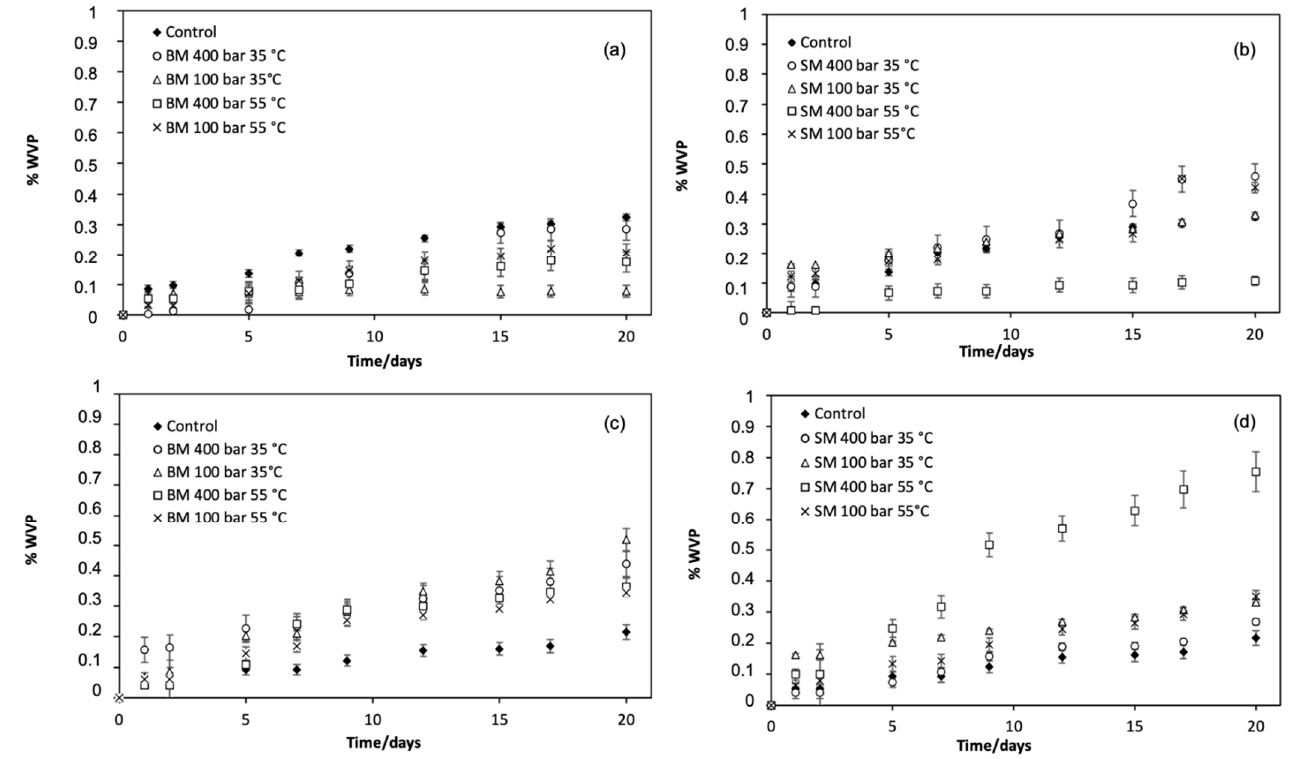
Figure 3. Percentage WVP of untreated PET/PP film (control) and OLE-impregnated films at ( a , b ) 20 °C and ( c , d ) 35 °C.